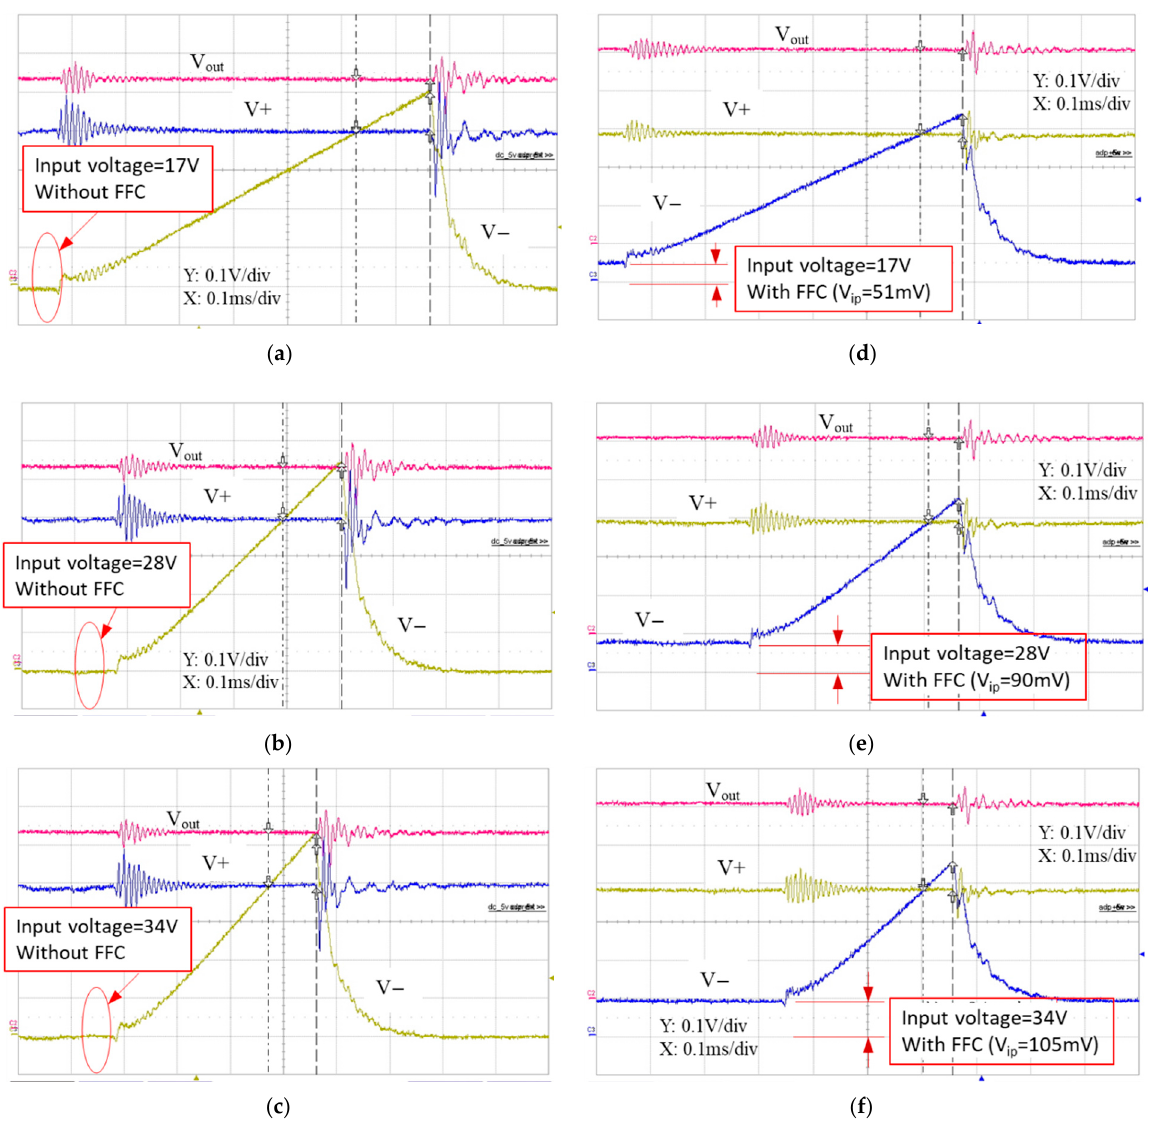
Figure 11. V − , V +, and Vout curves obtained by using the traditional peak current detection circuit with input voltage ( a ) 17V, ( c ) 18V, and ( e ) 34V, and by using the proposed FFC with input voltage ( b ) 17V, ( d ) 18V, and ( f ) 34V.